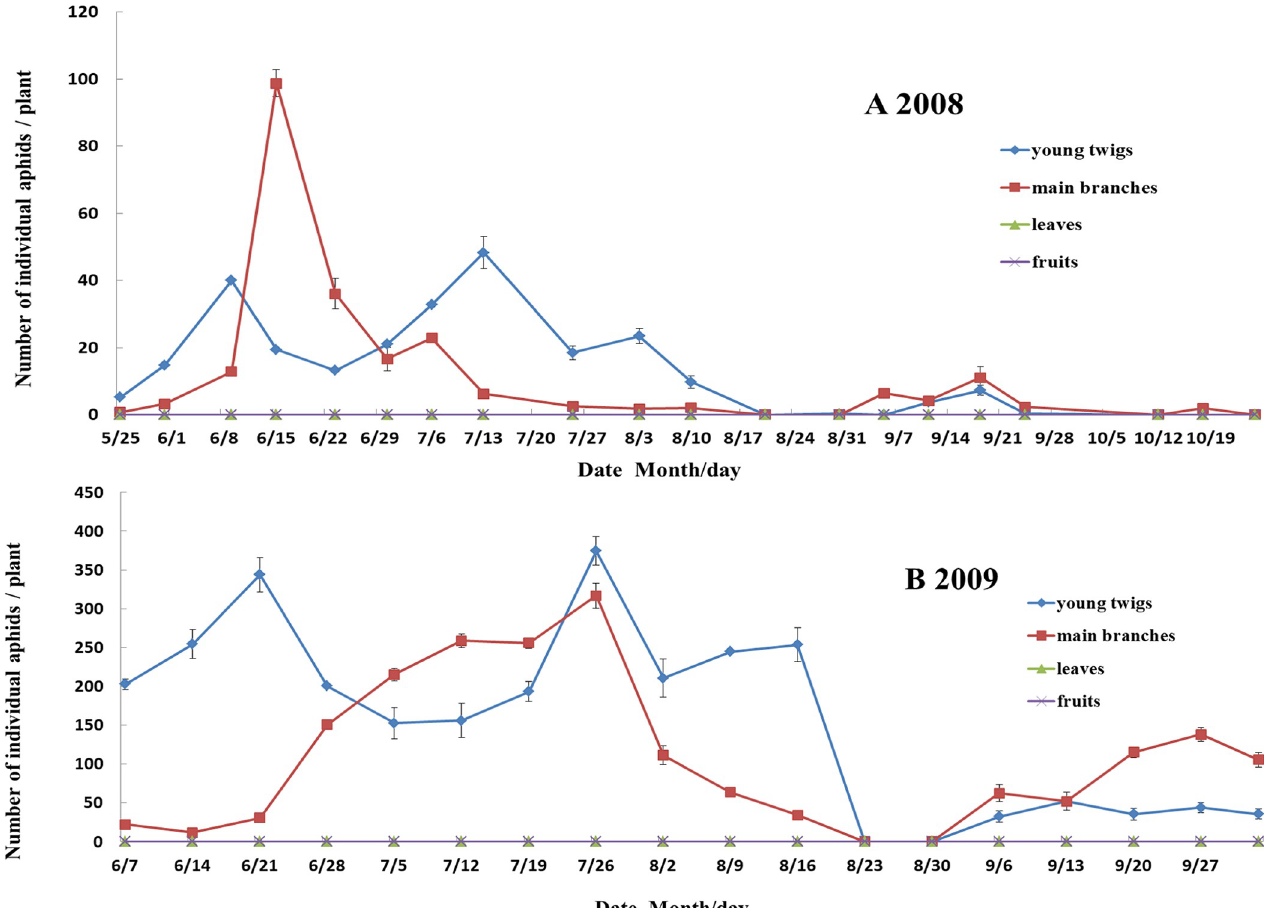
Fig 1. Dynamics of woolly apple aphid populations on different parts of apples, in an apple orchard in Laiyang, Shandong Province, China, in (A) 2008 and (B) 2009.